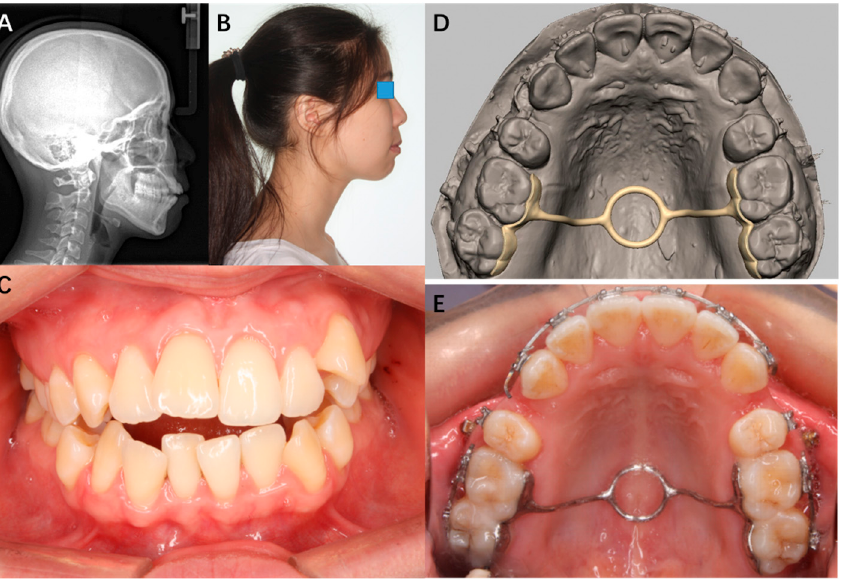
Figure 6. ( A ) The lateral cephalometric radiograph before treatment; ( B ) the profile before treatment; ( C ) conspicuous open bite in the anterior teeth; ( D ) a 3D TPA connecting maxillary first and second molars, see on a digital model; ( E ) the TPA applied intraorally.